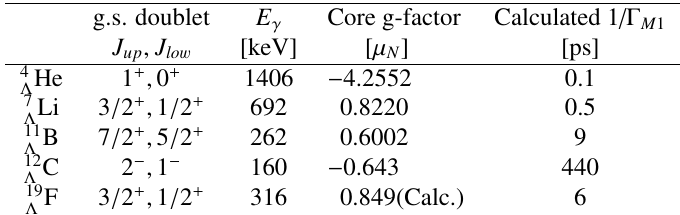
Table 1. Measured (cid:3) -spin-flip M1 transitions between hypernuclear ground-state doublets and calculated M1 decay